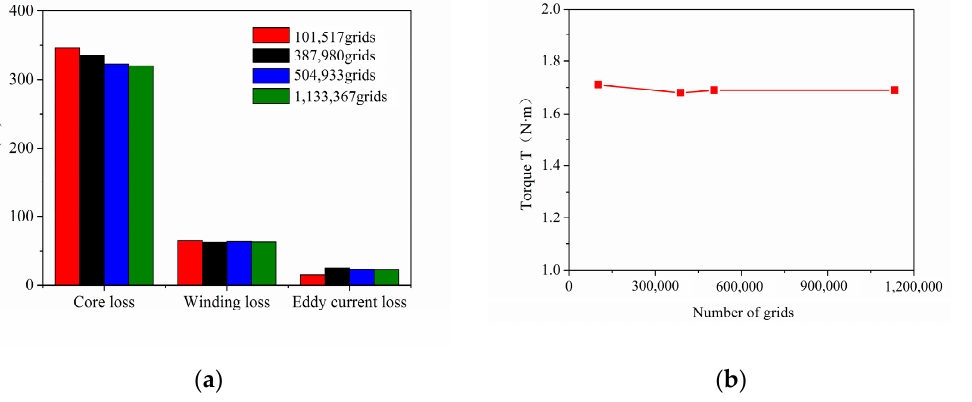
Figure 10. Grid independence verification. ( a ) Comparison of loss changes of various components under different grid numbers. ( b ) Torque variation under different grid numbers.